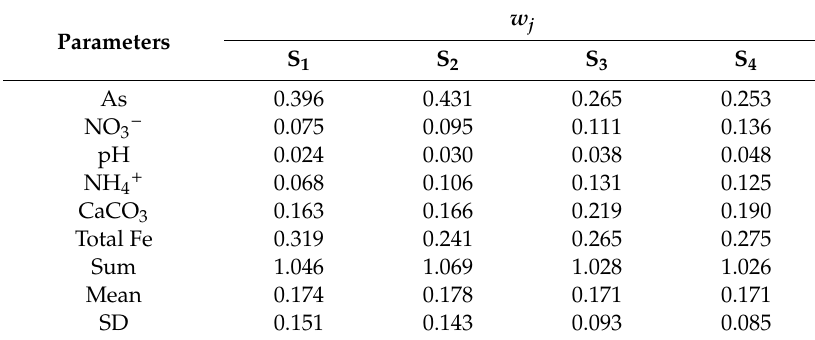
Table 5. Absolute group weights of parameters obtained from the pair-wise comparison.